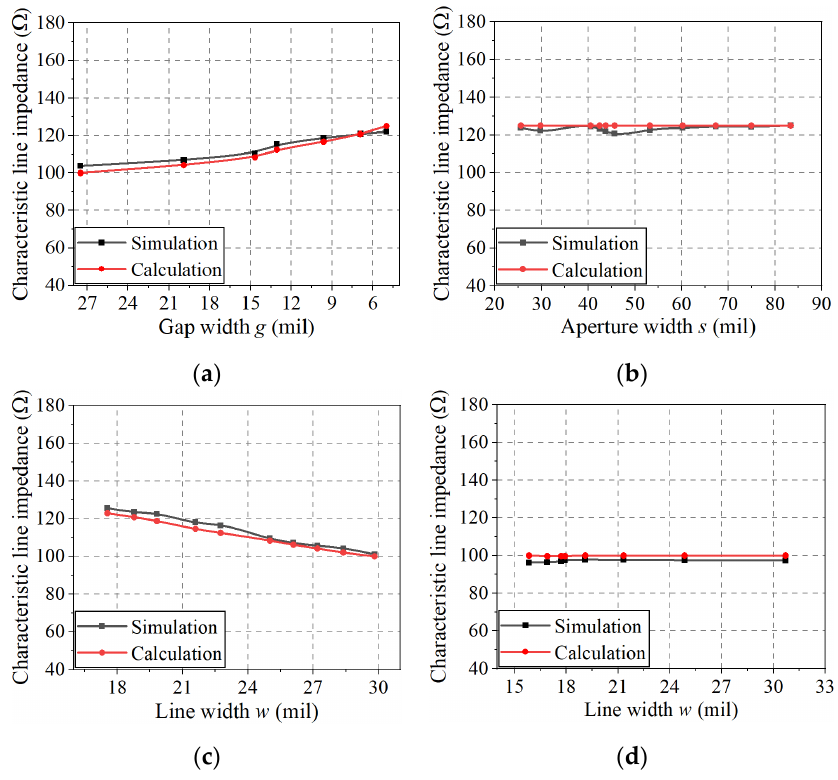
Figure 16. Calculated and EM-simulated characteristic line impedances of the proposed DL-to-PSL transition: ( a ) BB ′ to CC ′ , ( b ) CC ′ to DD ′ , ( c ) DD ′ to EE ′ , ( d ) EE ′ to FF ′ . transition: ( a ) BB (cid:48) to CC (cid:48) , ( b ) CC (cid:48) to DD (cid:48) , ( c ) DD (cid:48) to EE (cid:48) , ( d ) EE (cid:48) to FF (cid:48)